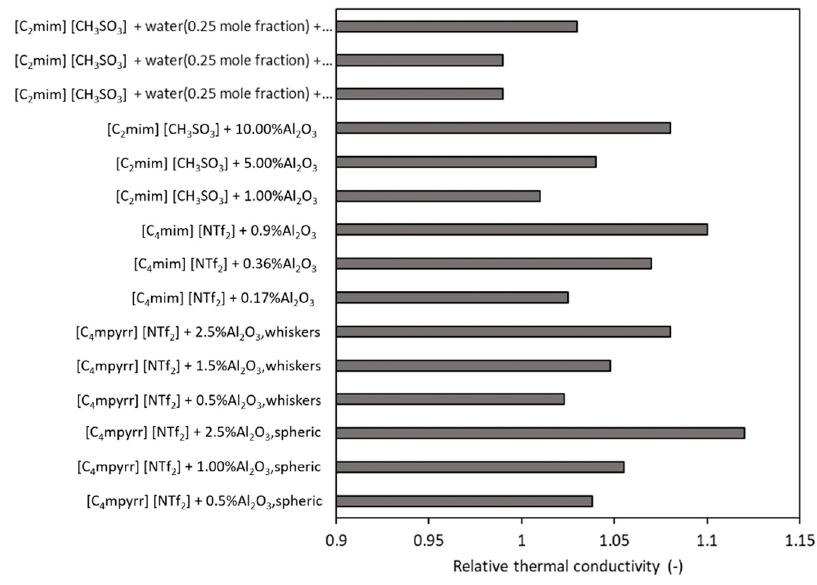
Figure 5. Influence of the base fluid on thermal conductivity of fluids with Al 2 O 3 nanoparticles.